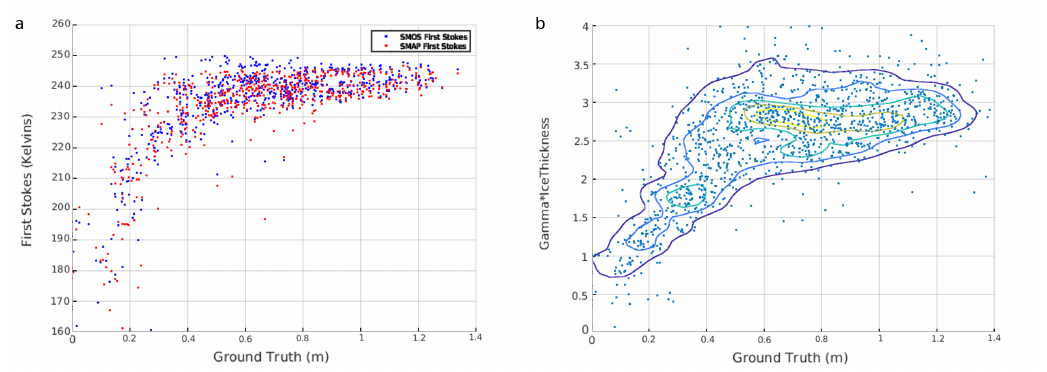
Figure 4. ( a ) SMOS and Soil Moisture Active Passive (SMAP) Brightness Temperatures (TB) First Stokes response to ULS derived ice thickness at 40 ◦ incidence angle. ( b ) Normalized thickness from the empirical retrieval against ground truth (see Equation